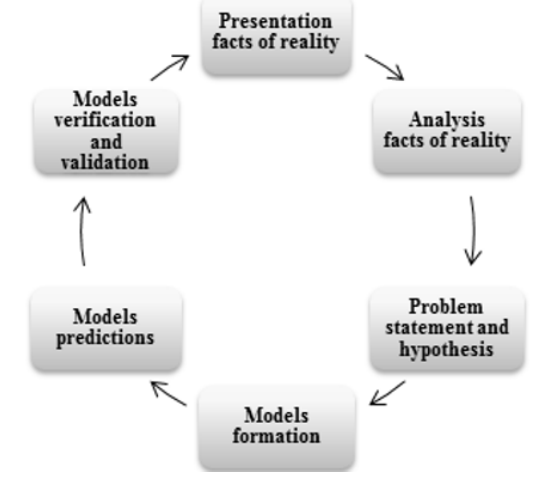
Fig.1. The CTLPh technology